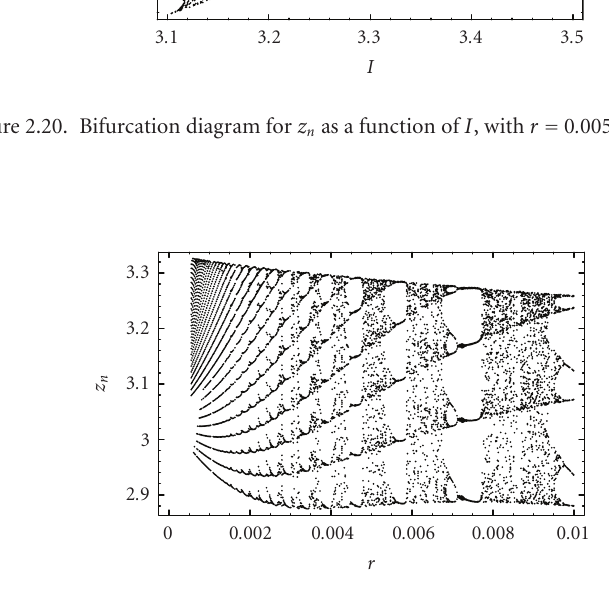
Figure 2.21. Bifurcation diagram for z n as a function of r , with I = 3 . 25 and s = 4 . 0.